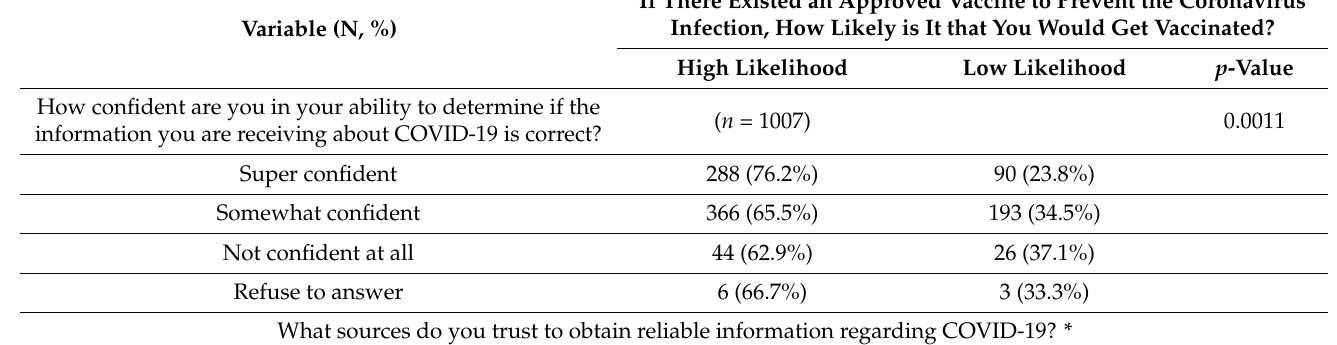
Table 2. COVID-19 Knowledge Acquisition and Perceptions of Vaccine